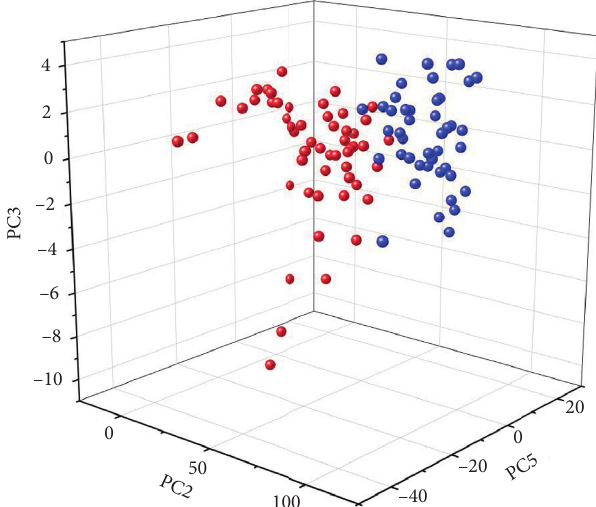
Figure 2: Three-dimensional scatter plot of the three principal components after PLS feature extraction. Red spheres represent CRF patients, and blue spheres represent control subjects.